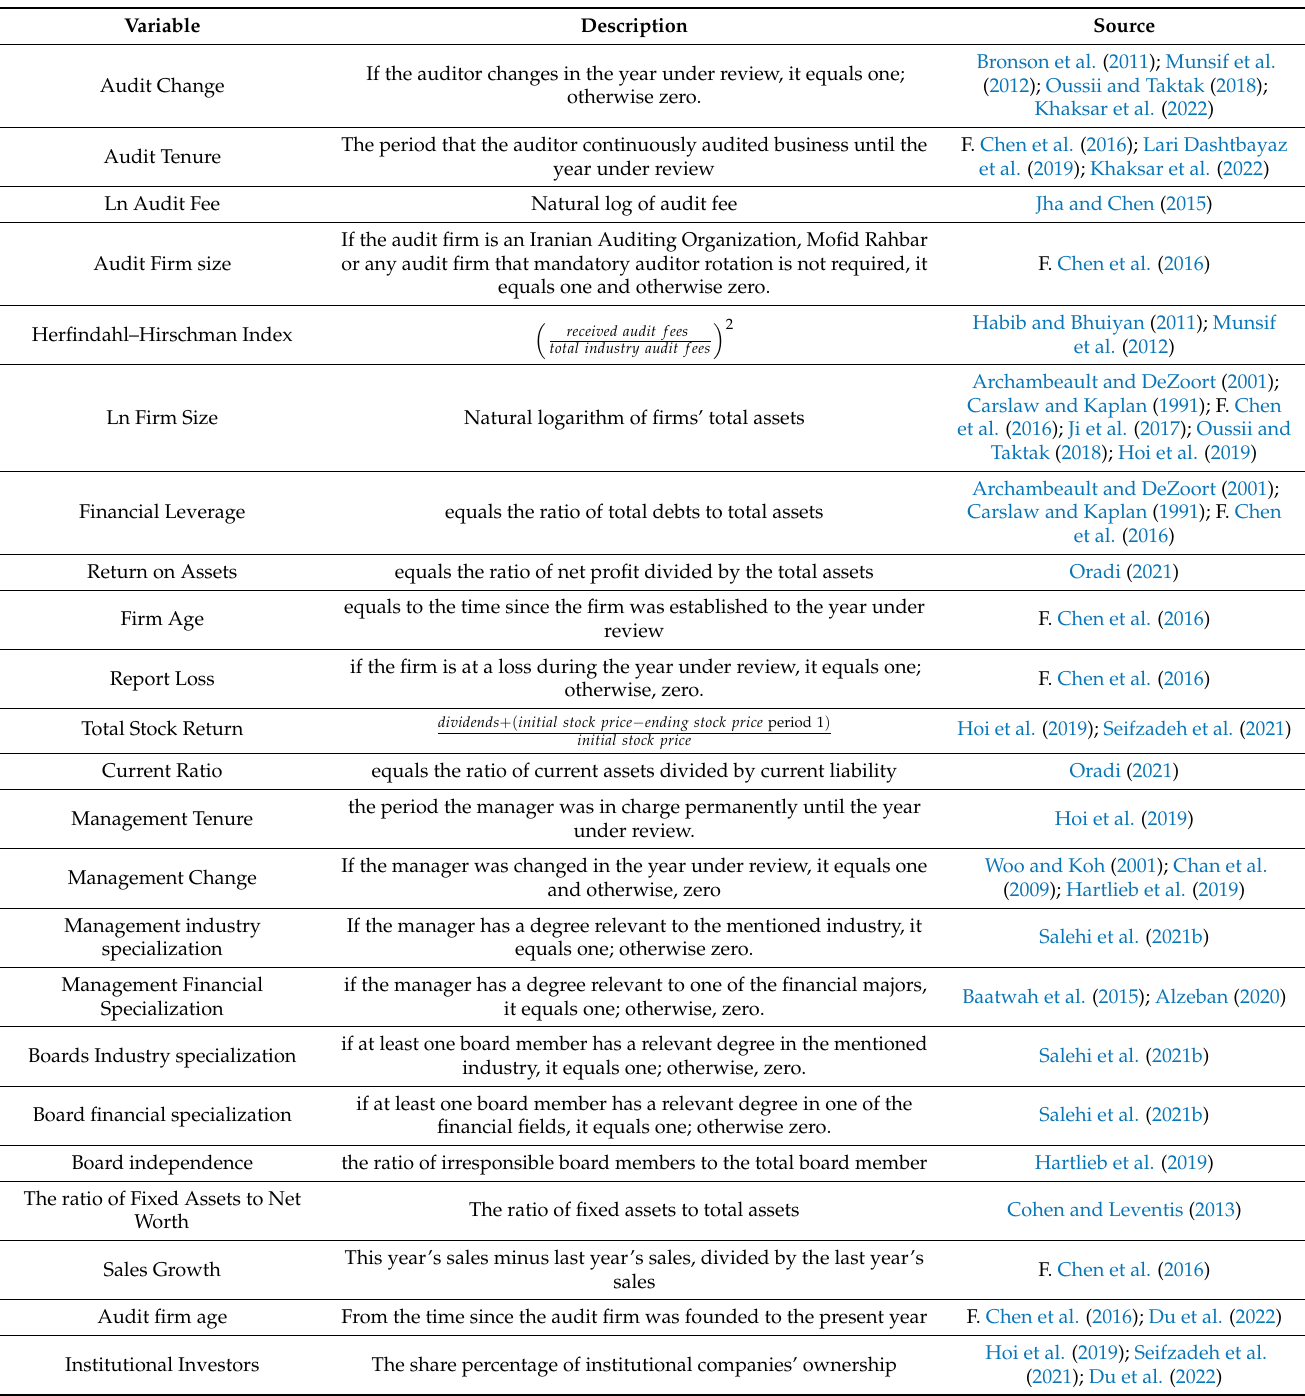
Table 1. The Control